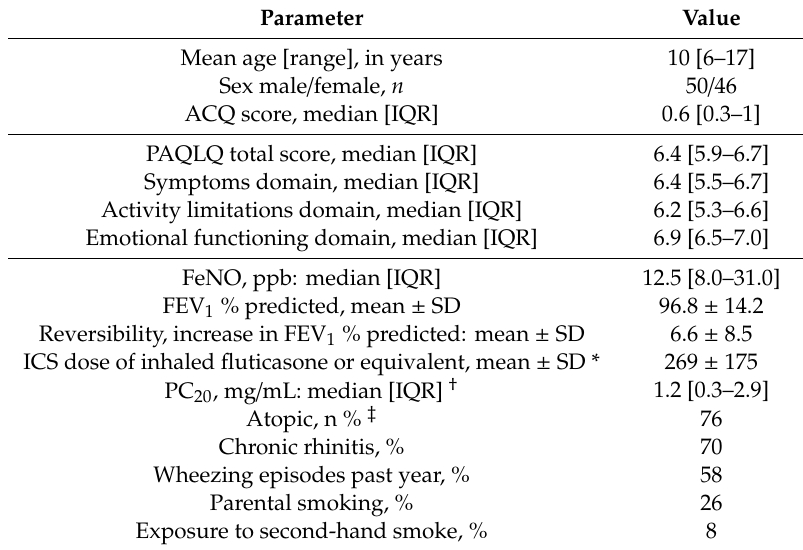
Table 2. Characteristics of the total population at baseline ( n =